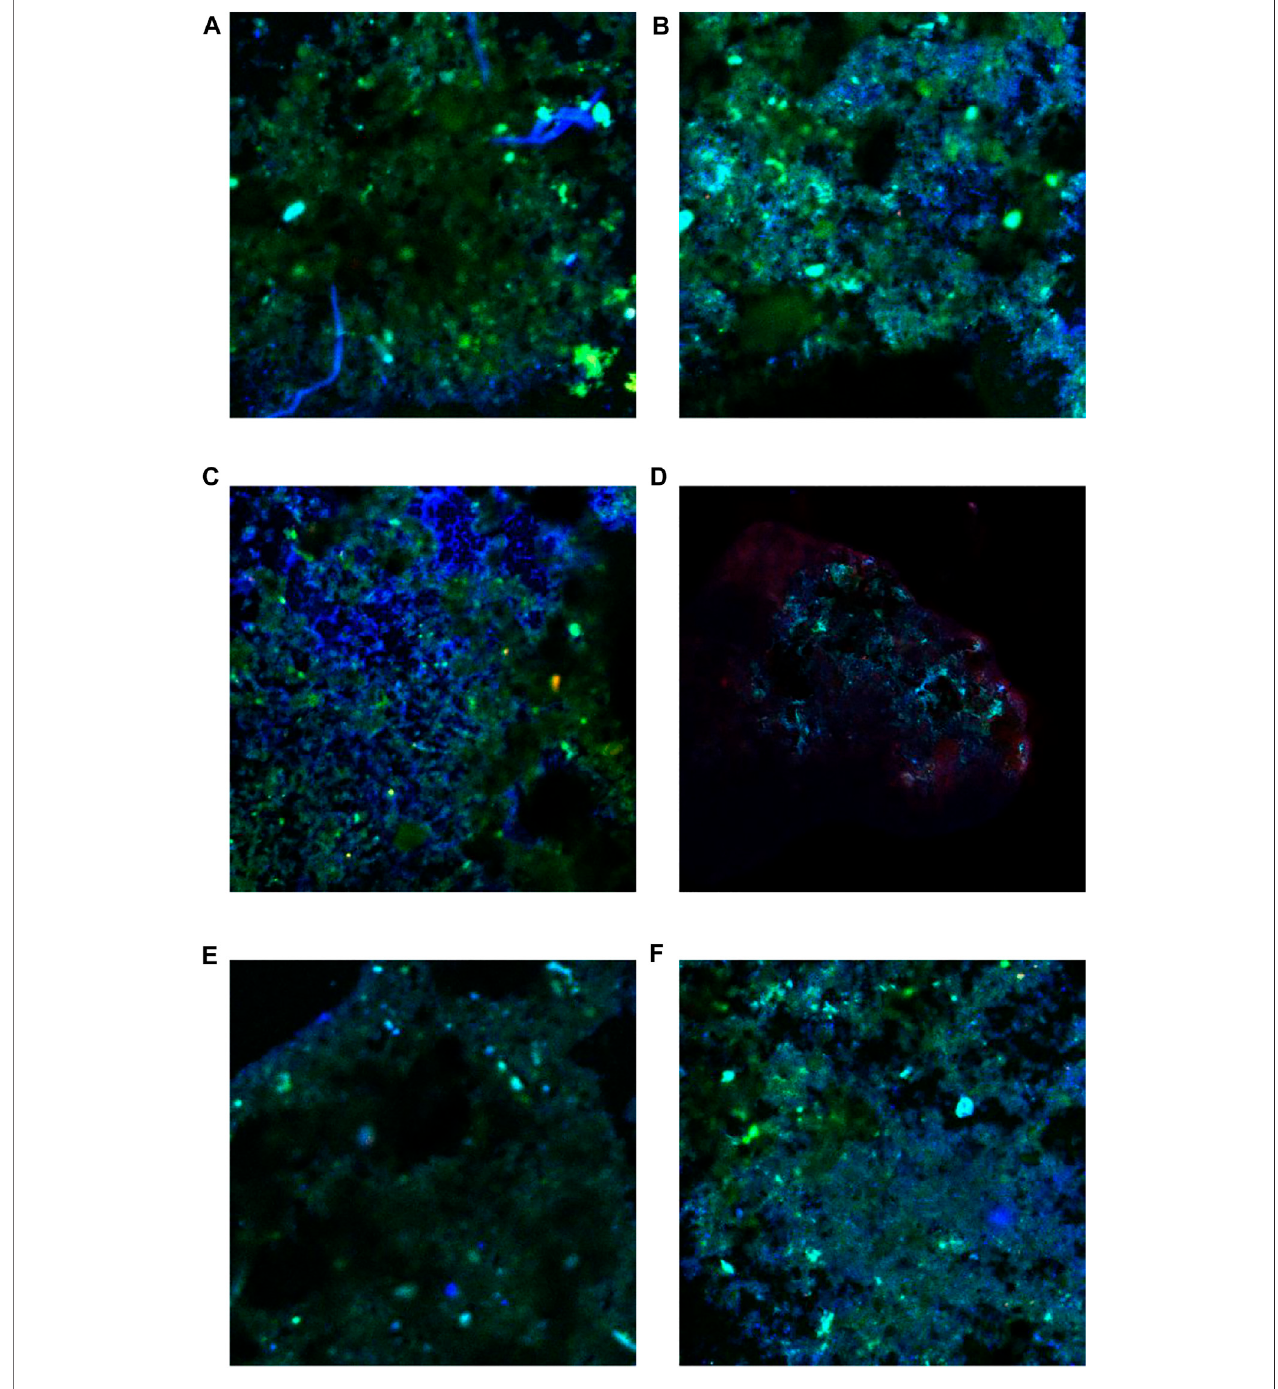
FIGURE5 | Fluorescence in situ hybridization diagram of methane-oxidizing bacteriaat each layer ofCB and CH. (A) Upper layer ofCB. (B) Upper layer ofCH. (C) Middle layer of CB. (D) Middle layer of CH. (E) Lower layer of CB. (F) Lower layer of CH.